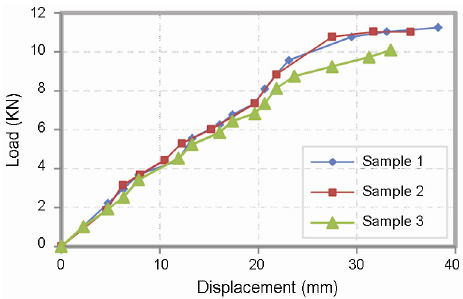
Fig. 17. Load-displacement curves for FRP-strengthened speci- mens with two layers of GFRP and with diagonal grooves